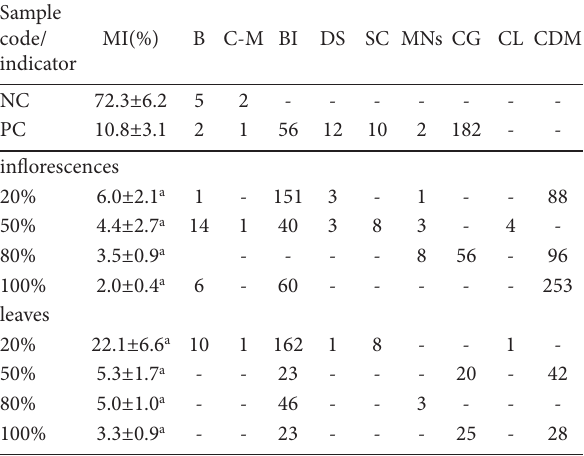
Table 1. Cytological effects in the meristematic cells of roots Allium cepa